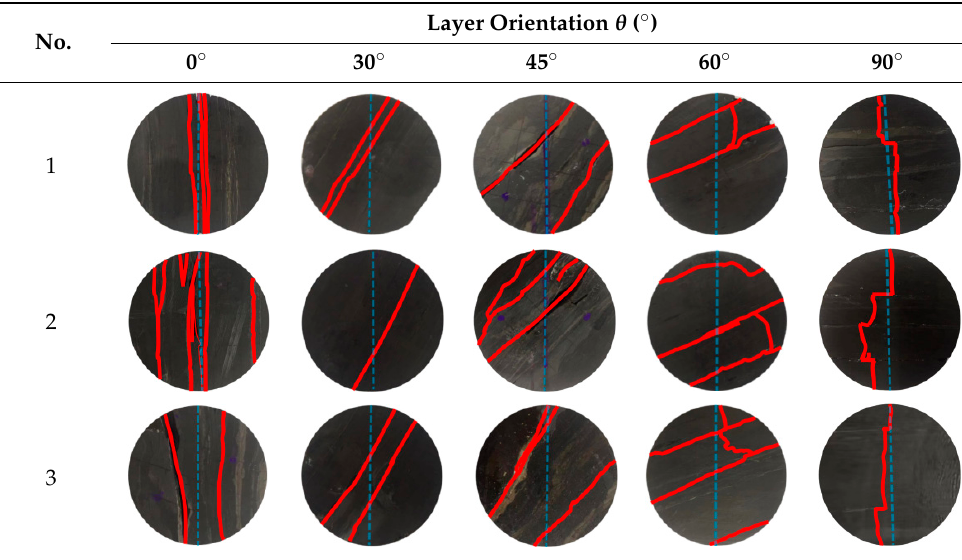
Table 4. Typical fracture morphology of continental shale with different layer orientations under Brazilian test.